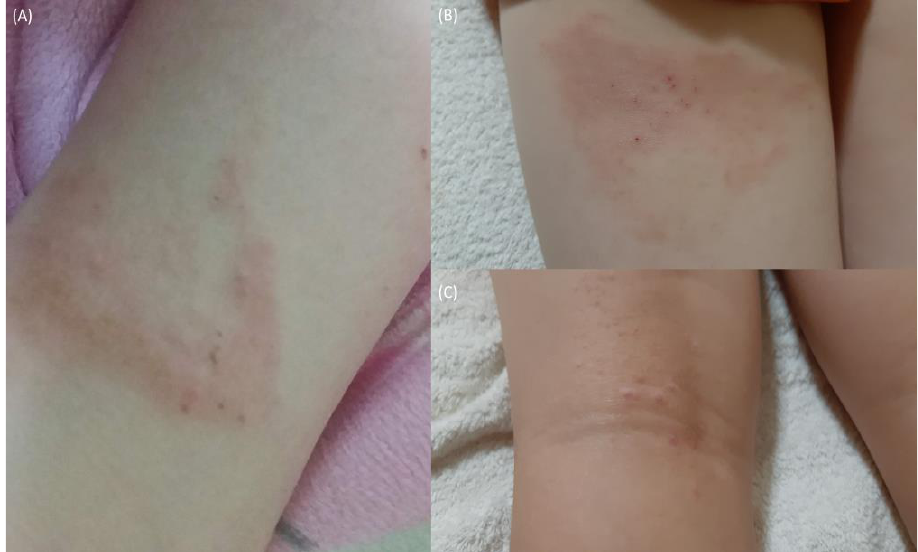
Figure 4. Recurrent AD flaring. ( A ) (16 March 2019) heat and pressure-triggered flare (posterior left knee). ( B ) (16 June 2021) heat and pressure-triggered flare (posterior left thigh). ( C ) (16 June 2021) scarring and nodulation (posterior left knee) following repeated flaring.